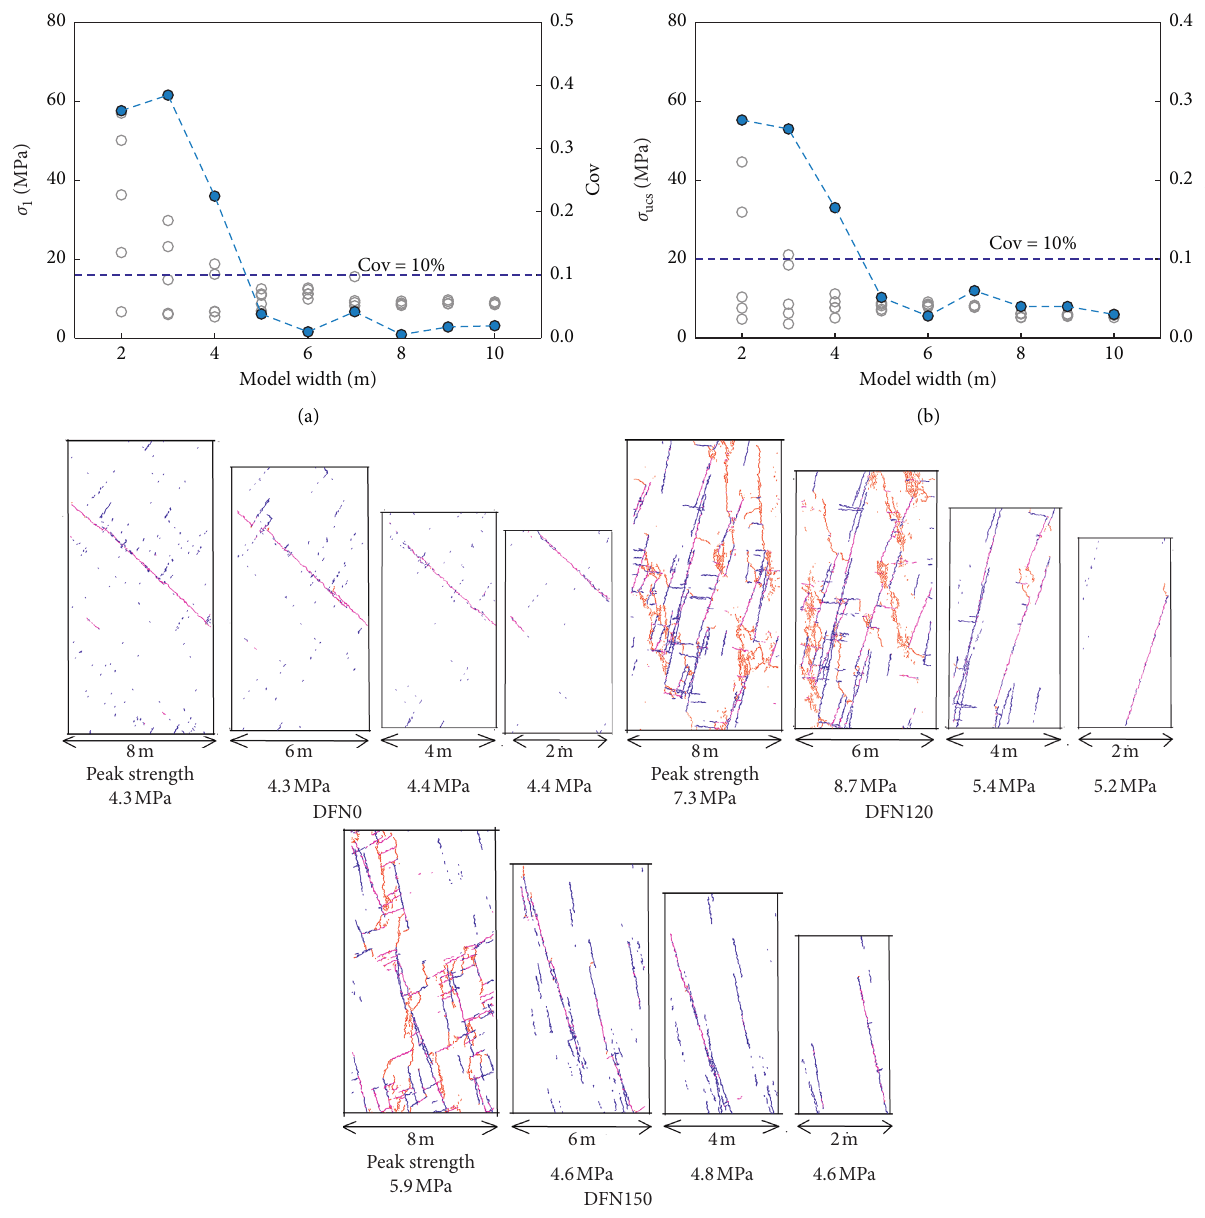
Figure 11: Effect of the model size on the UCS values of specimens (a) DFN150 and (b) DFN120. (c) Influence of the model size on the failure mode. Note that the specimens are generated based on the centre of the DFN model and the scale for each model is not the same for